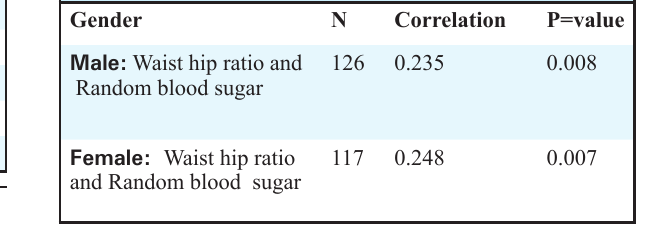
Table 4. Paired samples correlation of waist hip ratio and blood